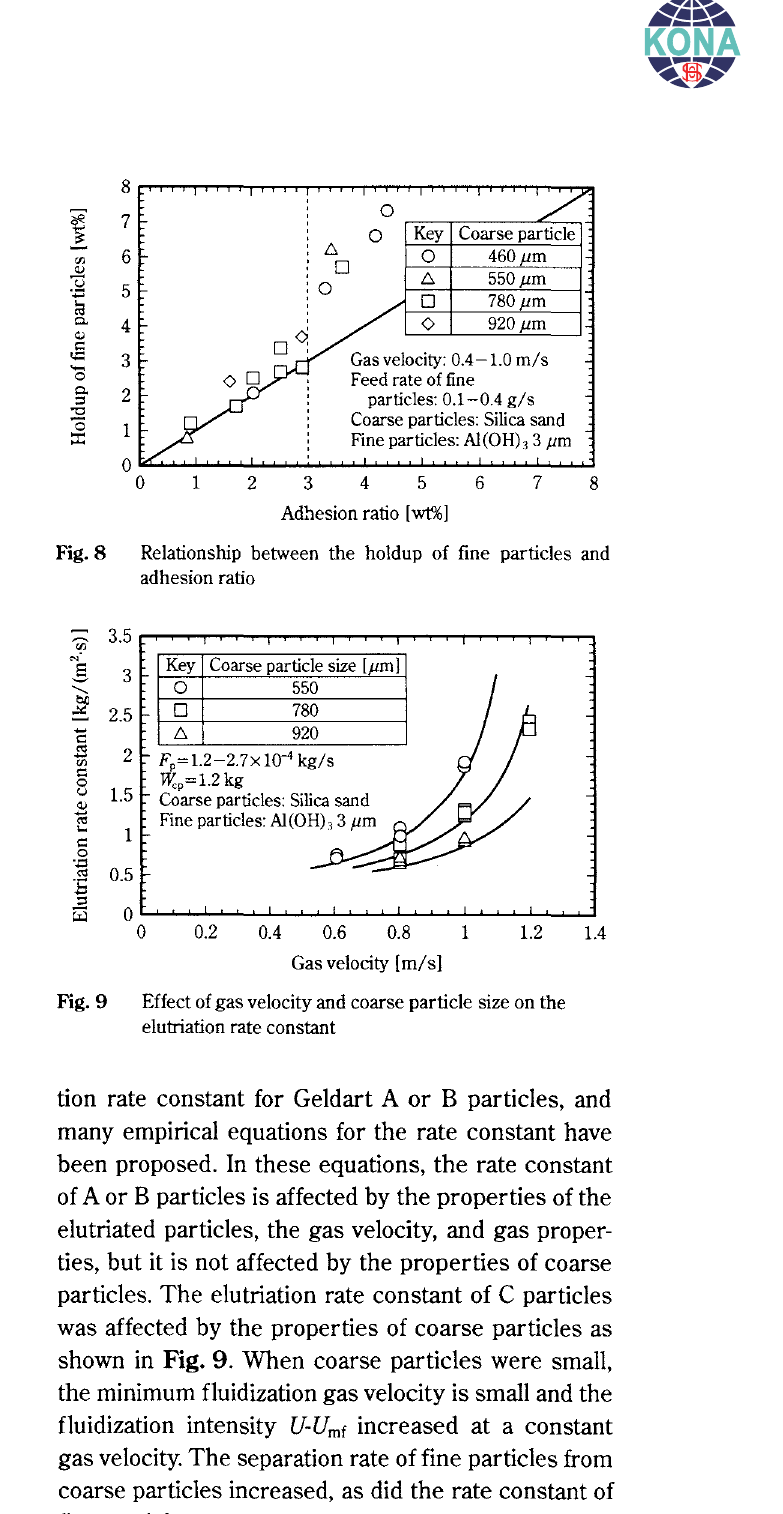
Fig. 8 Relationship between the holdup of fine particles and adhesion ratio